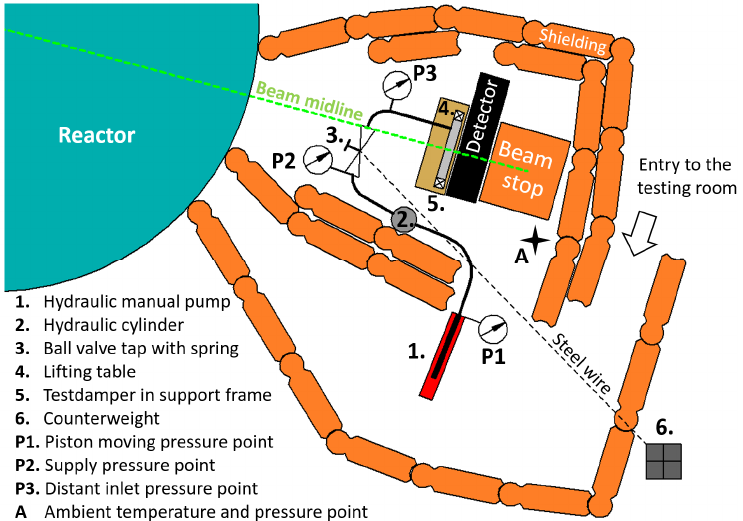
Figure 6. The layout of the neutron imaging setup at the RAD station of the Budapest Neutron Centre.